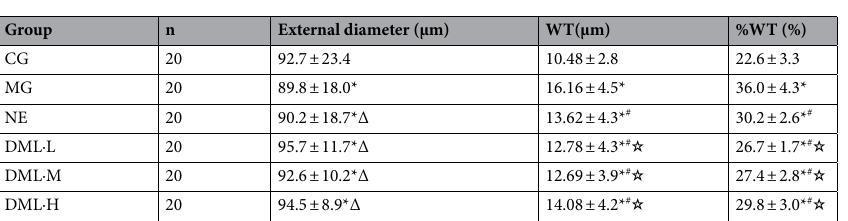
Table 2. Vessel dimensions of muscular pulmonary arteries in each group (mean ± SD). Data are expressed as means ± standard deviation (n = 20 per group). Plain control group-CG; CMS group-MG;